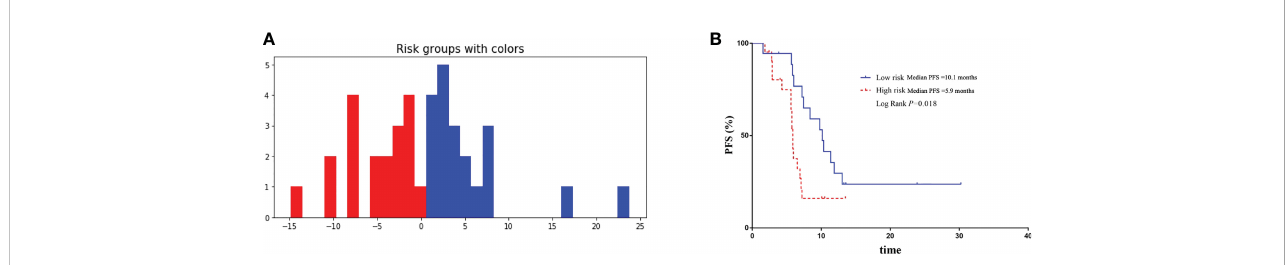
FIGURE 6 Validation of the performance of DeepSurv models in external validation cohort. (A) Patients in external validation cohort were divided into high-risk and low-risk group. (B) Comparison of Kaplan-Meier survival curves of PFS between high-risk and low-risk